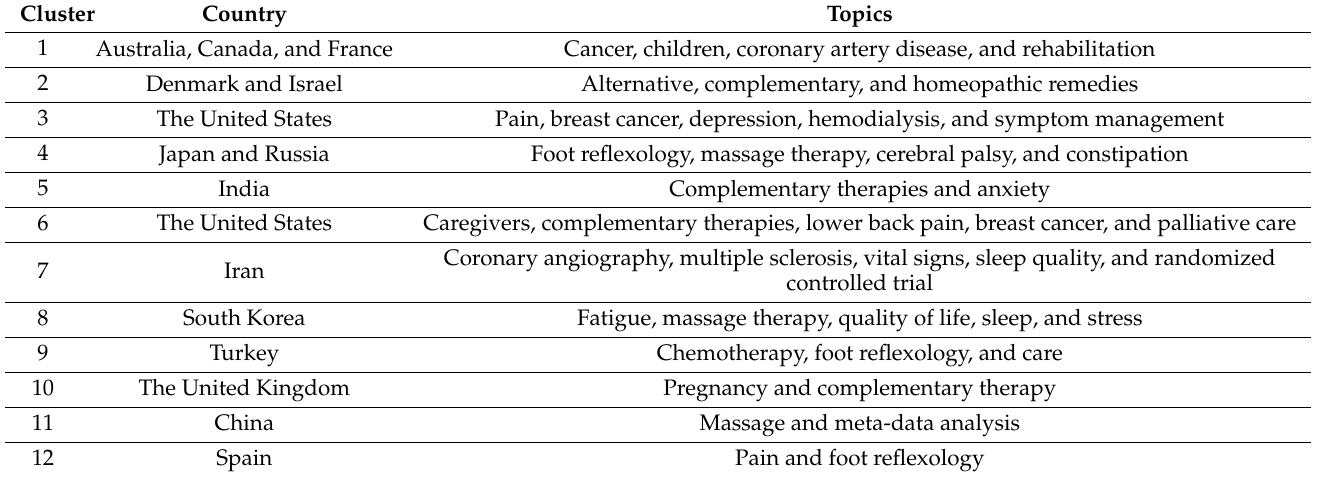
Table 2. Clusters of published papers by country and research topic.